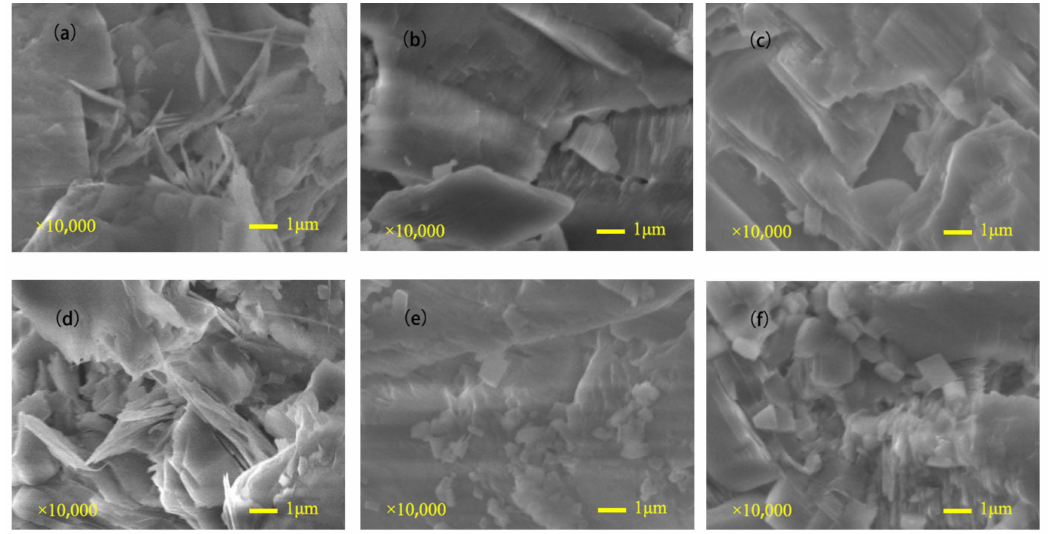
Figure 7. Microscopic appearance of sandstone with different saturation under freeze–thaw cycles: ( a ) 0%; ( b ) 30%; ( c ) 60%; ( d ) 75%; ( e ) 95%; ( f )